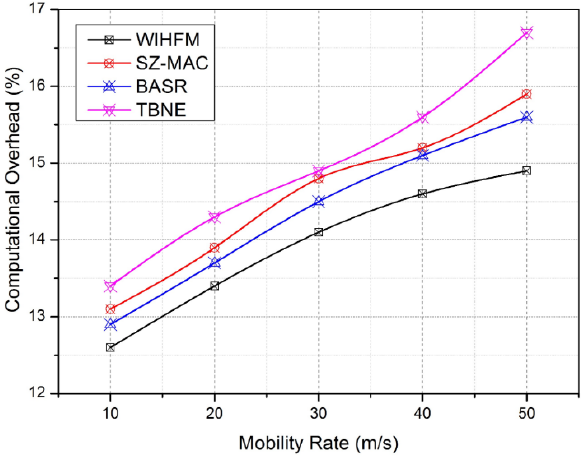
Figure 13. Computational